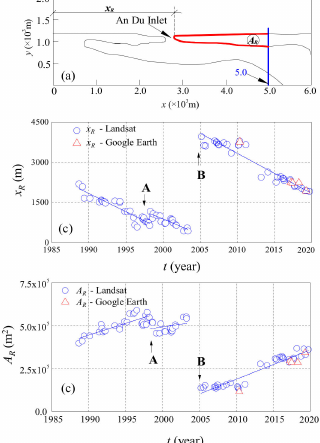
Figure 9. ( a ) Definition sketch of the right sand spit of An Du Inlet, ( b ) Time variations of the tip coordinate ( x R ), ( c ) Time variations of the sand spit area ( A R